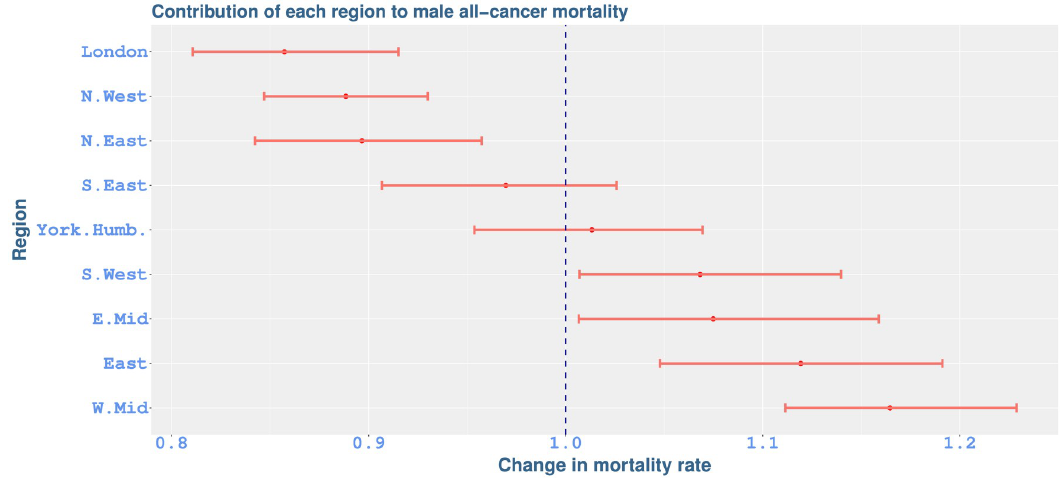
Fig 3. Contribution of each region to all-cancer mortality rates with respect to average age-at-diagnosis (dots), with 95% credible intervals (bars). The vertical line indicates the average regional impact.